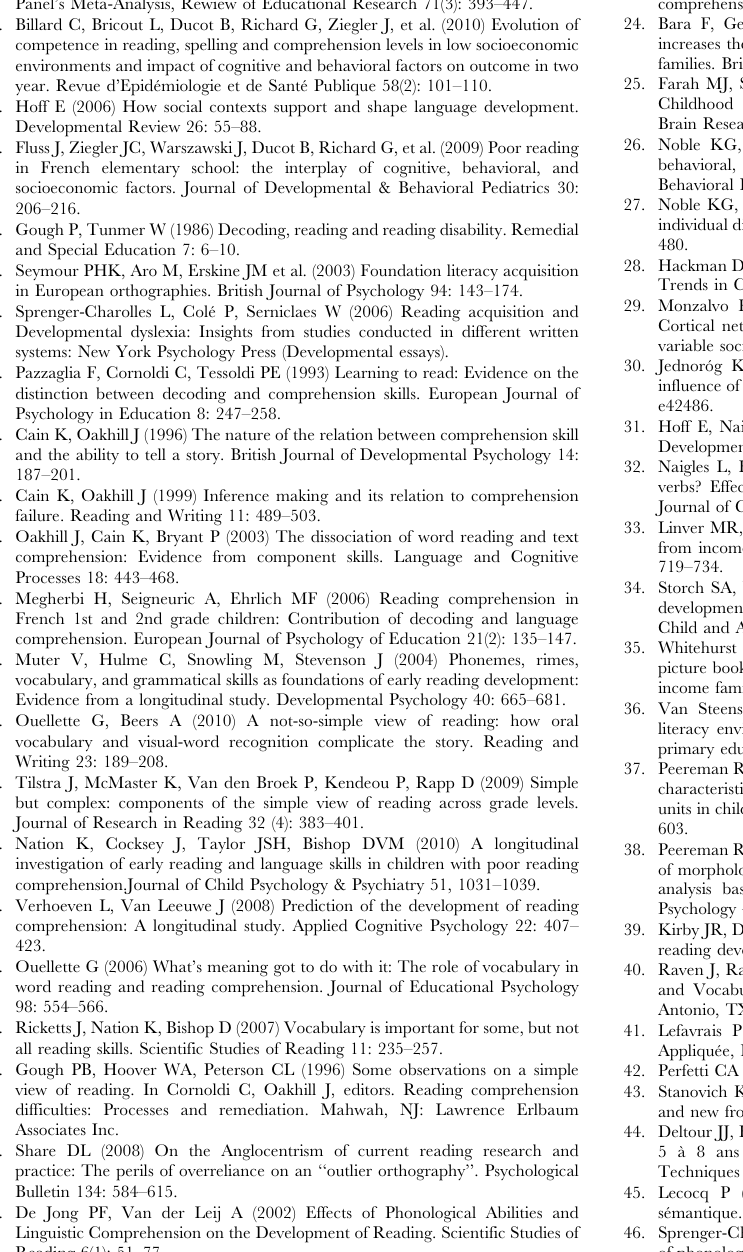
Figure S2 Reading comprehension: